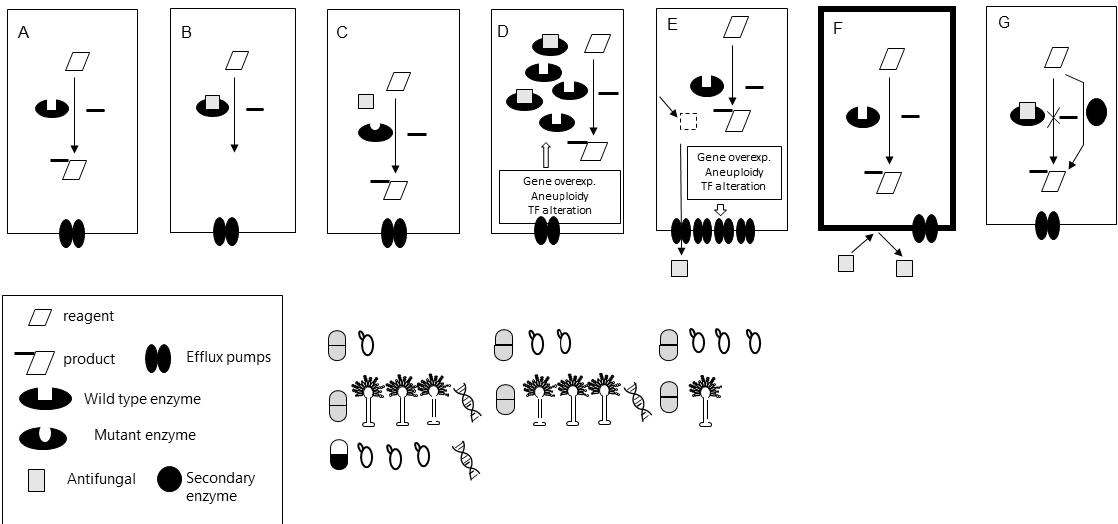
Figure 2. ( A ) Essential enzymatic reaction for a fungal cell. ( B ) Inhibition of the reaction by the antifungal drug. ( C , D ) Alterations of the interaction drug-enzyme. ( C ) Mutation on the drug target (less efficient or non-interaction). ( D ) Overexpression of the drug-target. In the box are the most commonly described mechanisms leading to overexpression. ( E , F ) Reduction of the cytoplasmic drug concentration. ( E ) Overexpression of efflux pumps (e.g., CDRs) by different underlying mechanisms (described in the box). ( F ) Impermeability. The drug is not trespassing the membrane (e.g., no transporter available as happens with 5-fluorocytosine and Histoplasma capsulatum . ( G ) Metabolic bypass. Grey and black and White pill symbols represent azole and echinocandin antifungals resistance mechanisms, respectively. Yeast and Aspergillus graphics under each of the mechanisms represent the description of each particular mechanism in Candida spp. and Aspergillus spp. respectively. The number of Yeasts and Aspergillus graphs show the relative prevalence of each of the mechanisms in Candida and Aspergillus spp. clinical strains, respectively. DNA graphs represent molecular tools’ availability to detect that particular mechanism in a drug/fungi